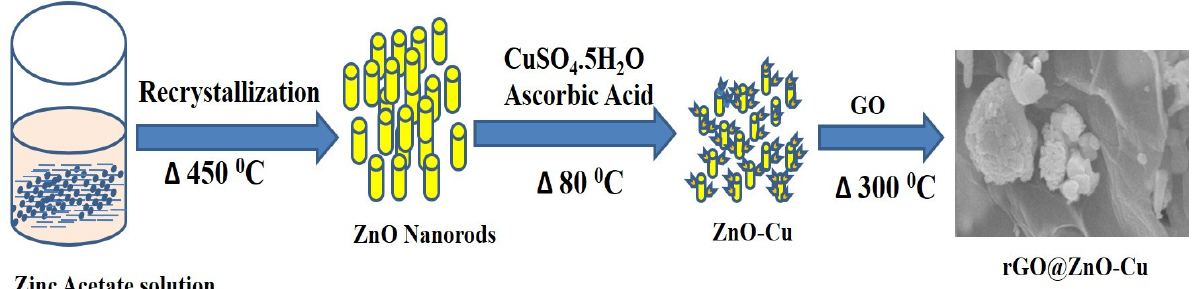
Figure 1. Schematic representation ofthe synthesis of rGO@ZnO–Cu nanocomposite. The SEM micrographs of the ZnO–Cu and rGO@ZnO–Cu nanocomposites are pre-